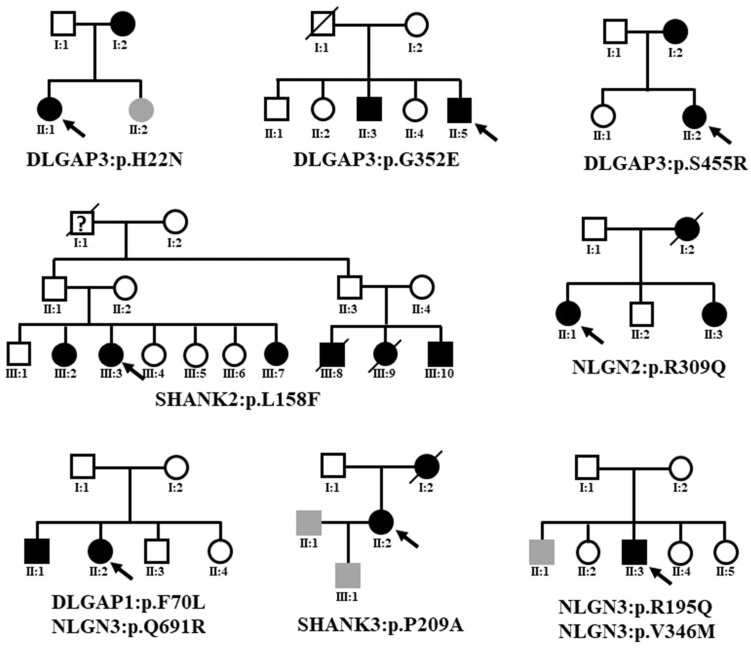
Familial relationships of the patients with schizophrenia with rare coding variants identified in this study. The black symbol indicates schizophrenia. The gray symbol indicates an intellectual disability. The question mark indicates unclear psychosis. Black arrows indicate the index case subjects.